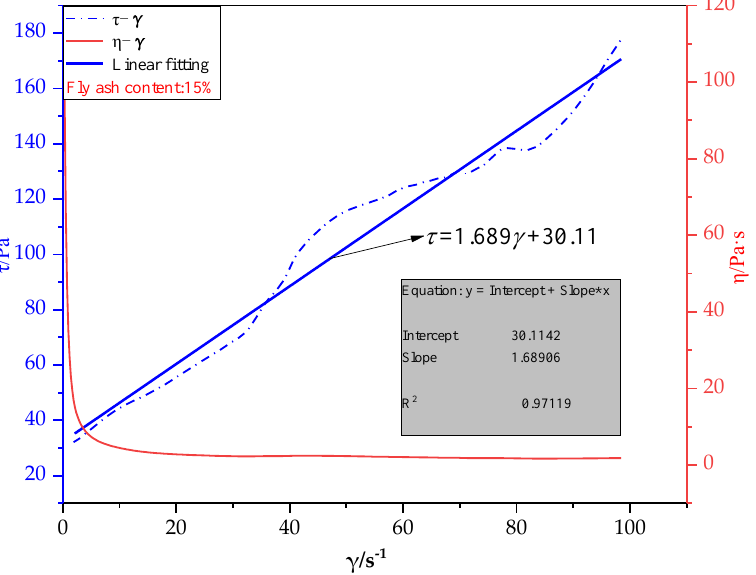
Figure 5. The relation curve between shear stress and shear rate and the relation curve between viscosity and shear rate.